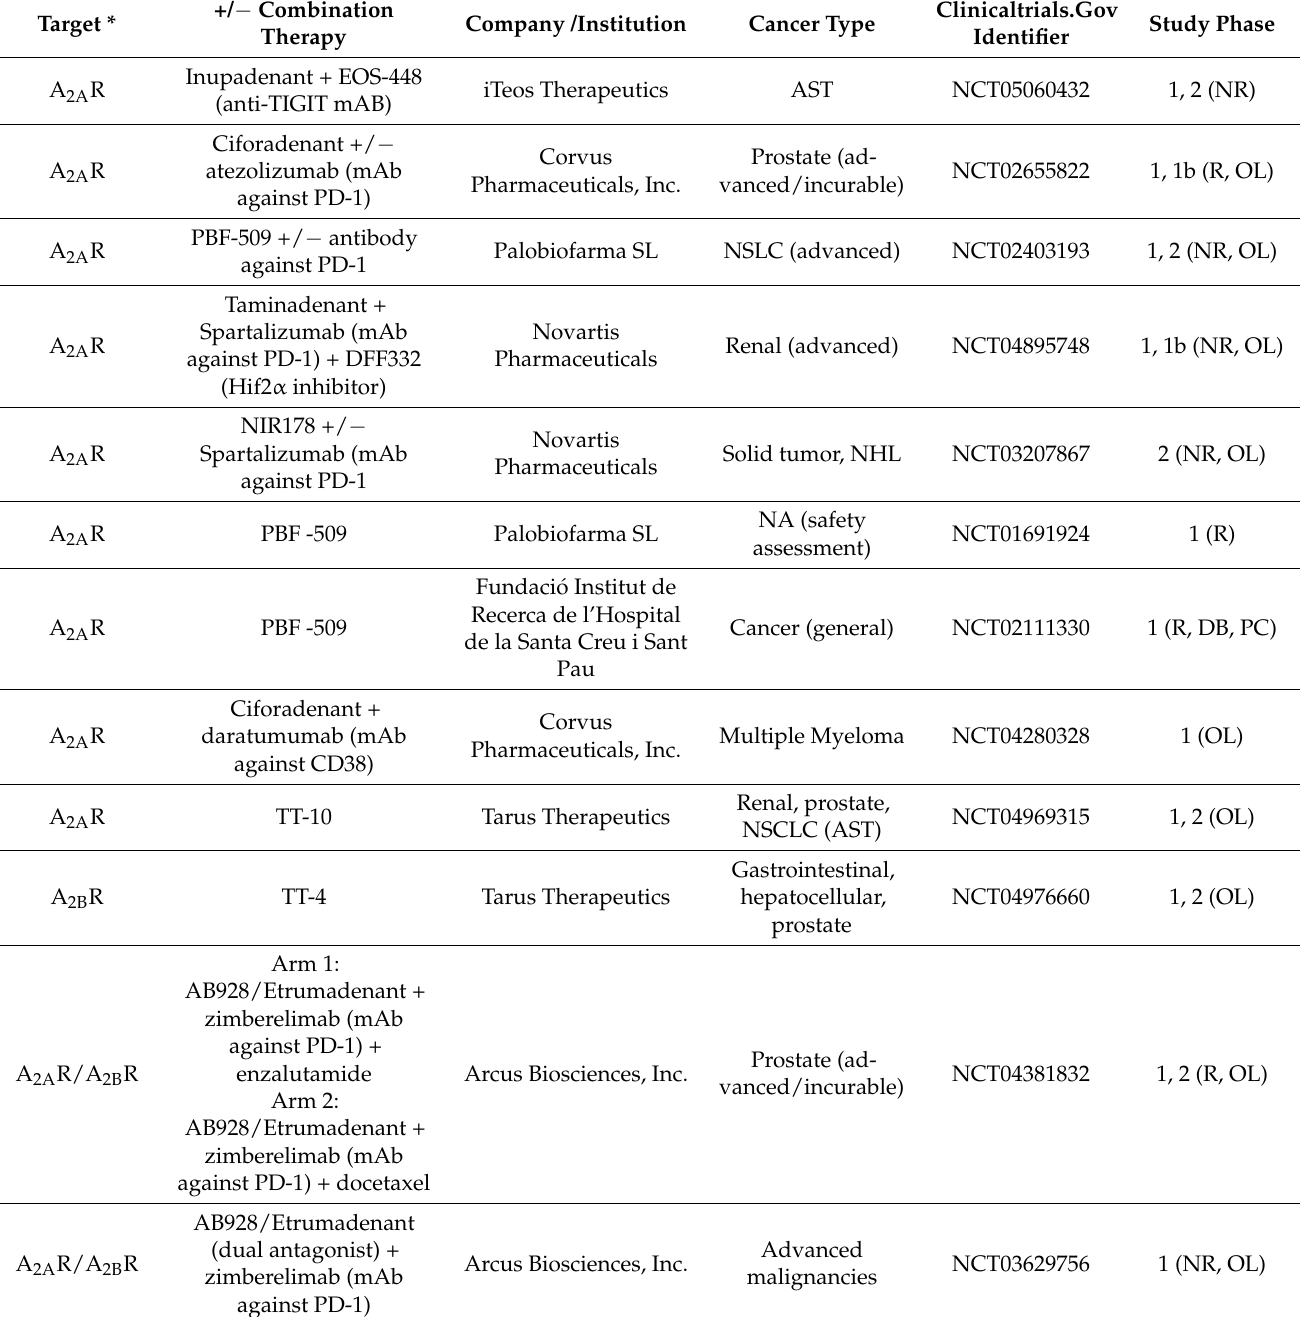
Table 1. Ongoing clinical trials registered at Clinicaltrials.gov in which A 2A or A 2B receptors are targeted to combat